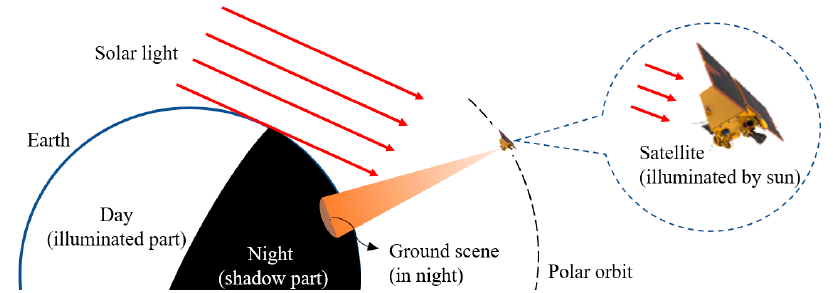
Figure 1. Solar light affection on nighttime image.